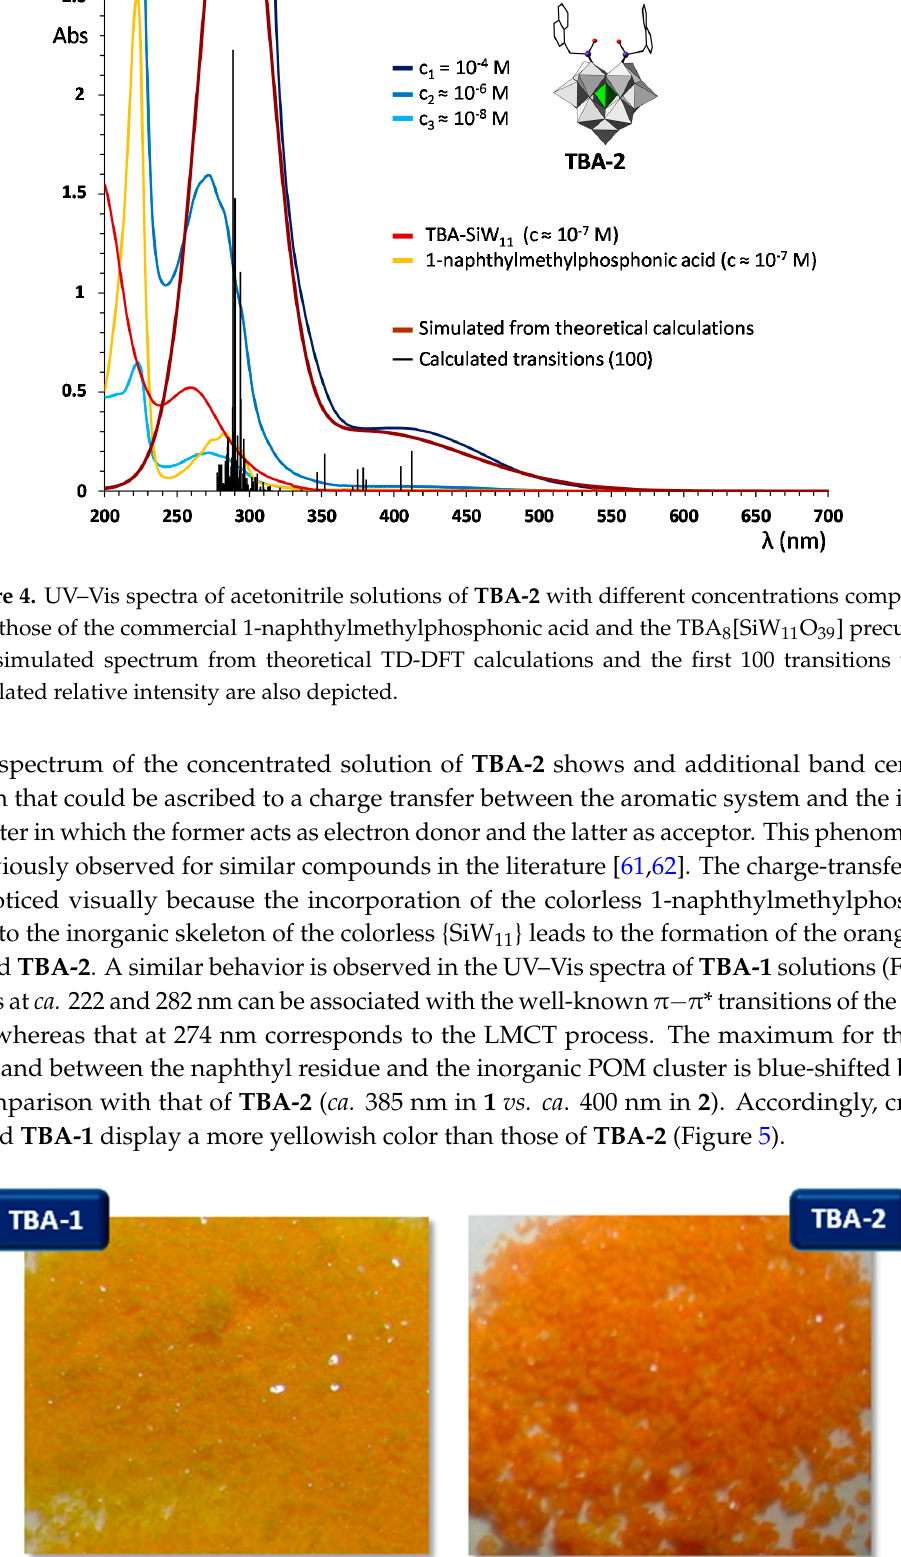
Figure 5. Photographs of the crystalline batches of TBA-1 and TBA-2 upon being left to dry in air overnight.